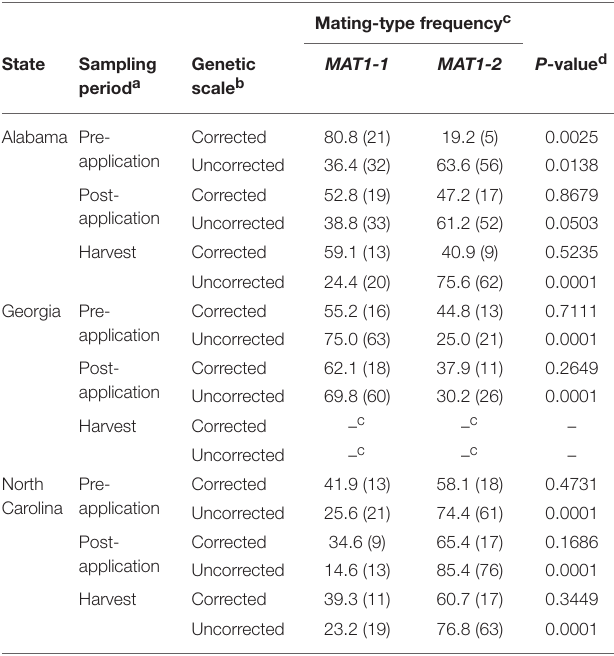
TABLE 5 | Frequency and distribution of mating-type ( MAT ) genes among isolates of Aspergillus flavus in soil from maize fields in southeastern United States treated with Afla-Guard and AF36 biocontrol strains in